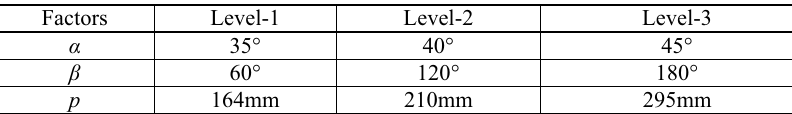
Table 1. Factors and levels.